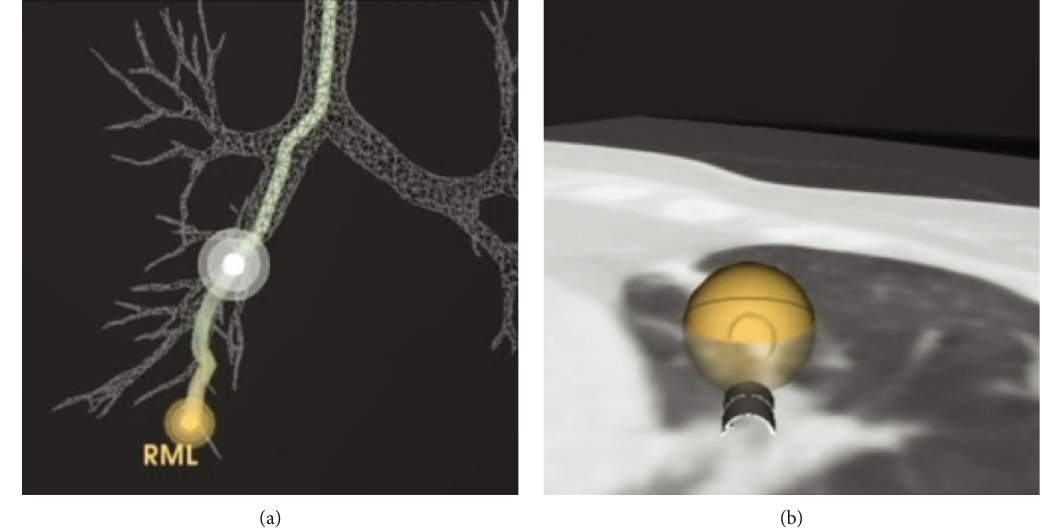
Figure 2: (a) Monarch robotic-assisted navigational bronchoscopy path to the right middle lobe lung nodule. (b) Axial computed tomography imaging superimposed on the robotic-assisted pathway to the right middle lobe lung